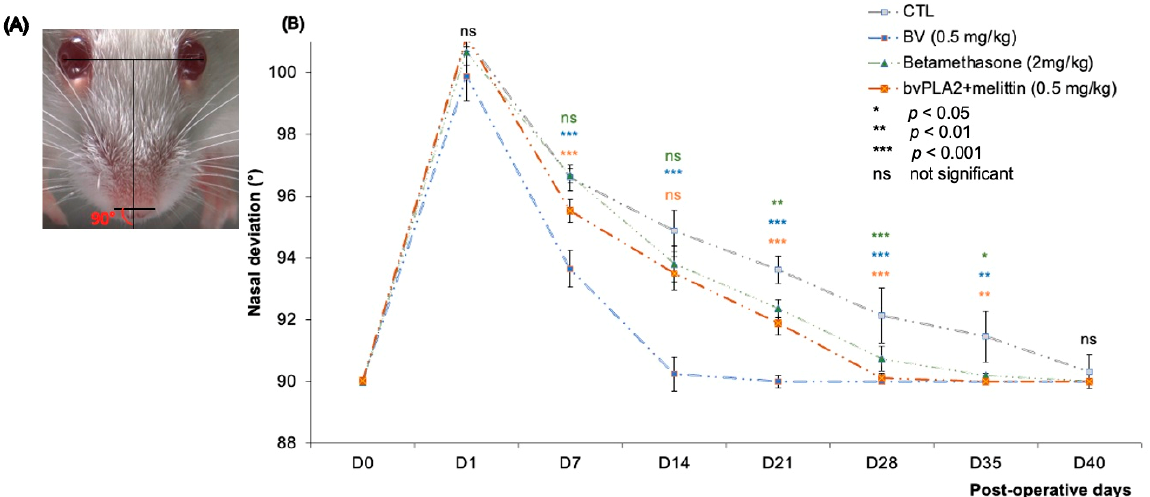
Figure 4. ( A ) The angle α was measured between the midsagittal plane and the line connecting the nostrils. ( B ) Measurement of the angle α at different postoperative days after FN branches SS. The difference among the groups was analyzed by t -test. Compared with the BV-treated groups, the control group had significantly lower values with the measurement (*** p < 0.001, ** p < 0.01). Note that a return to the normal nasal position was observed on D14 in the BV treated group (*** p < 0.001) versus D40 in the control group.